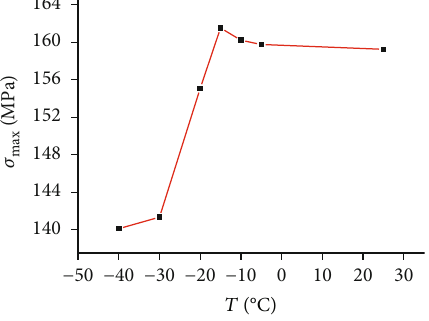
Figure 7: Peak stress vs. temperature for granite. Figure 8: Failure strain vs. temperature for